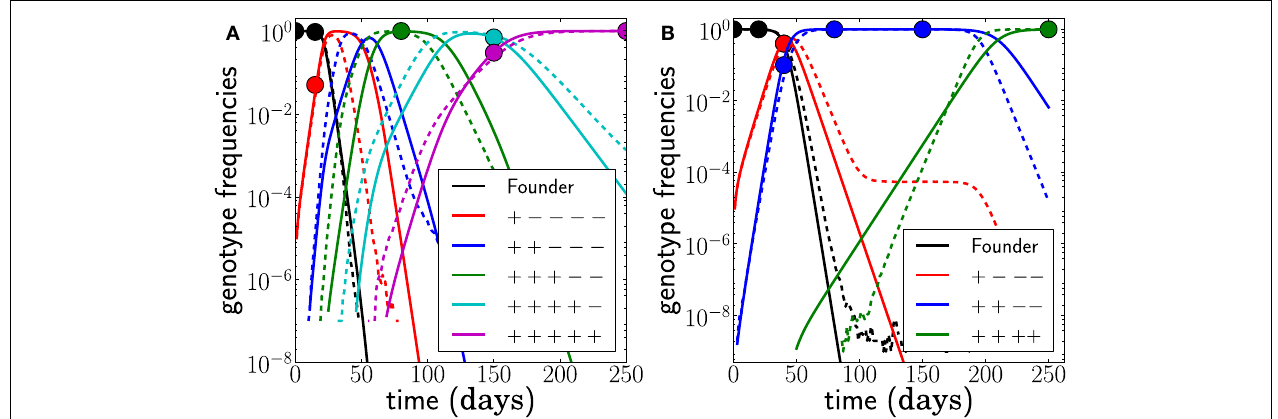
genotype containing only one of the two mutations is not viable. Hence the effective mutation rate into the genotype is µ 2 = 10 − 10 and the waiting time for this genotype is longer. Note that the population size is N = 10 9 in this example ( r = 0, µ = 10 − 5 ).The last escape only appears once the previous escape mutations have reached frequency one, and the seeding time is quite